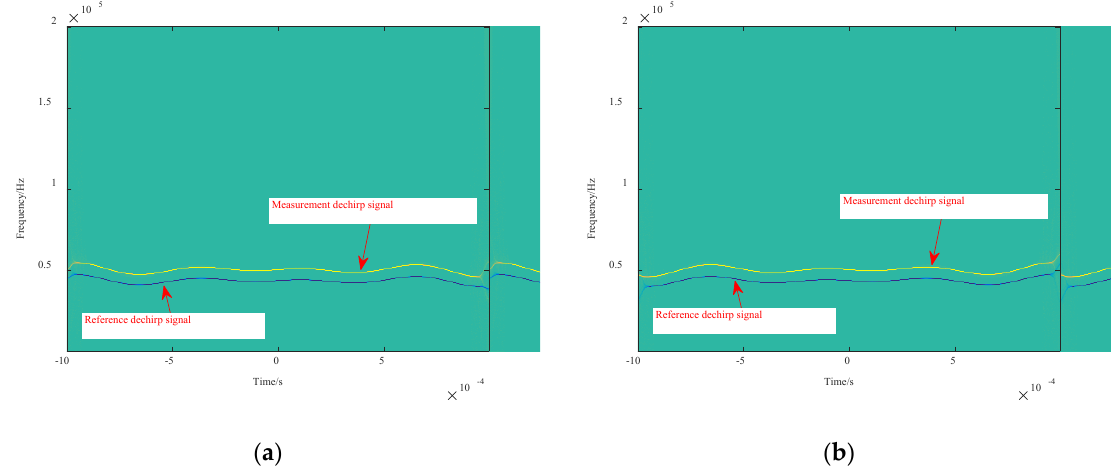
Figure 6. ( a ) The second − order SST results of up measurement and up reference dechirp signals; ( b ) The second − order SST results of down measurement and down reference dechirp signals.